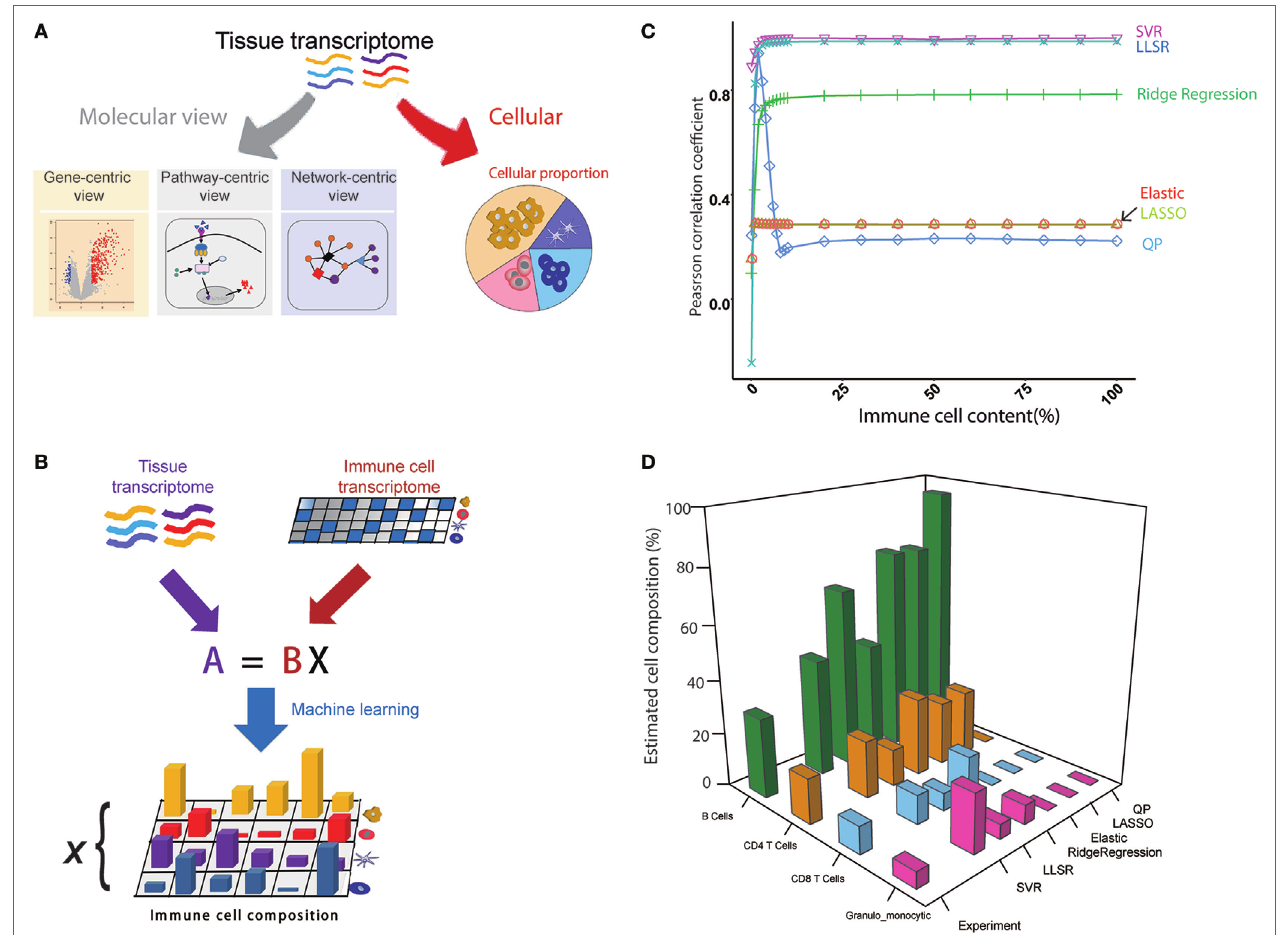
FIGURe 1 | An overview of the seq-ImmuCC model. (A) Molecular and cellular views of the tissue transcriptome. (B) Schematics of the seq-ImmuCC model. (C) Comparison of six machine learning methods over the simulated data. (d) Comparison of six machine learning methods with the experimental